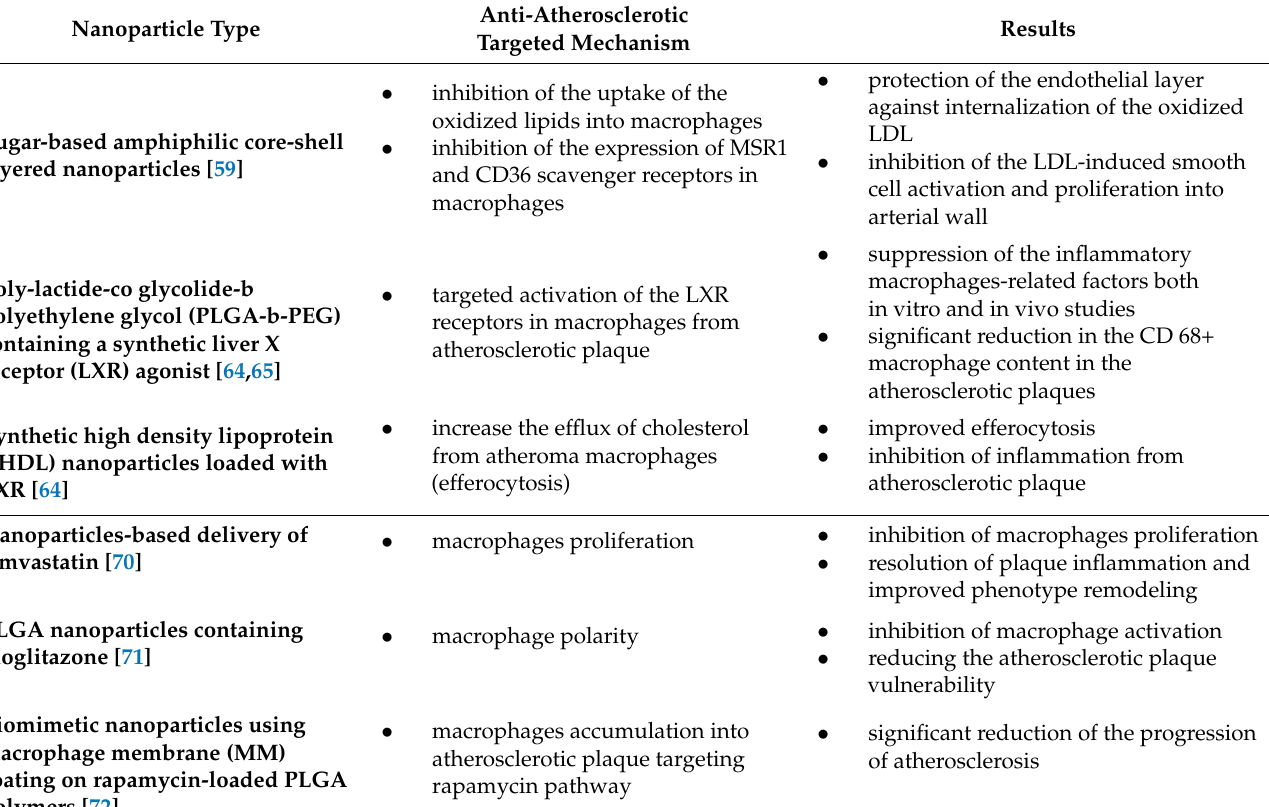
Table 3. Nanoparticles targeting macrophage